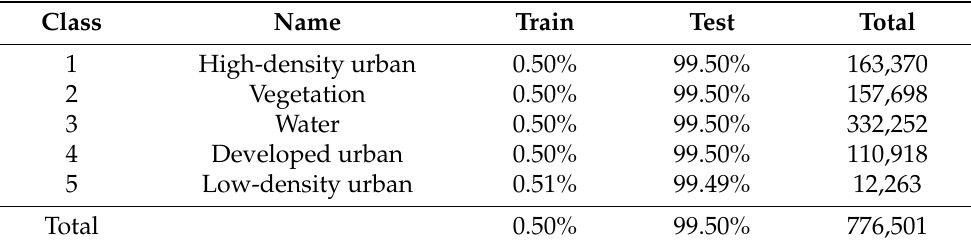
Figure 6. San Francisco dataset. ( a ) PauliRGB image (Red: double-bounce scattering power. Green: volume scattering power. Blue: surface scattering power). ( b ) Ground truth map. Table 4. The image information of AIRSAR San Francisco dataset.